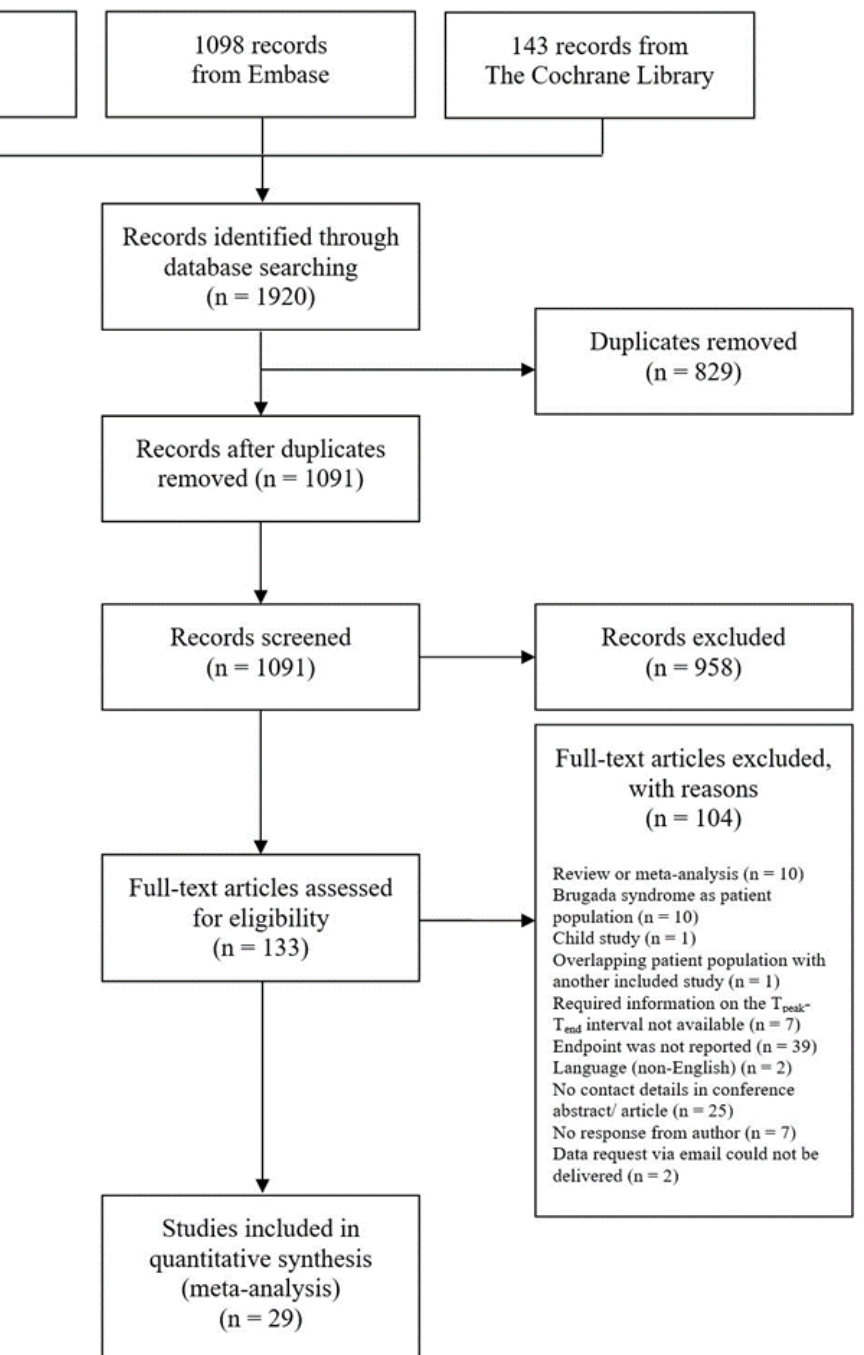
Figure 1. Flow chart of the search strategy and study selection process.